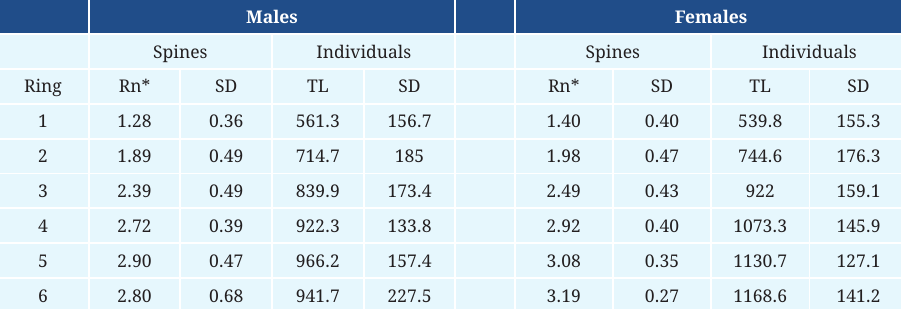
TABLE 2 | Mean values and standard deviations of distances from core to each annual growth marks (rings) and back-calculated mean total lengths and standard deviations at age (individuals) for Pseudoplatystoma corruscans , per sex. Abbreviations: Rn*=corrected spine radius length TL=total length (cm), SD=standard deviation.